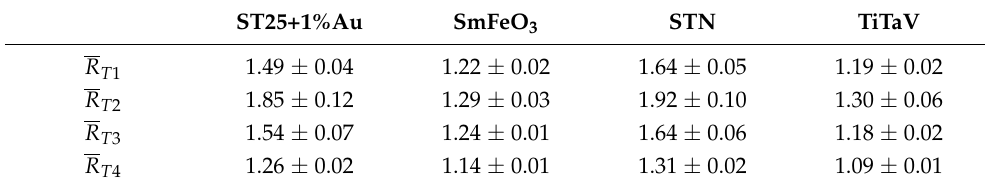
Figure 3. Average sensor responses (R) to the blood collected during patient follow-up. Response R averaged on all patients and relative standard error (reported numerically in Table 1) of each sensor at the different blood collection times (red, T1, n = 30; green, T2, n = 22; yellow, T3, n = 29; blue, T4, n = 28). Table 2. Average responses R ± their standard error of the four sensors to T1, T2, T3 and T4 of Figure